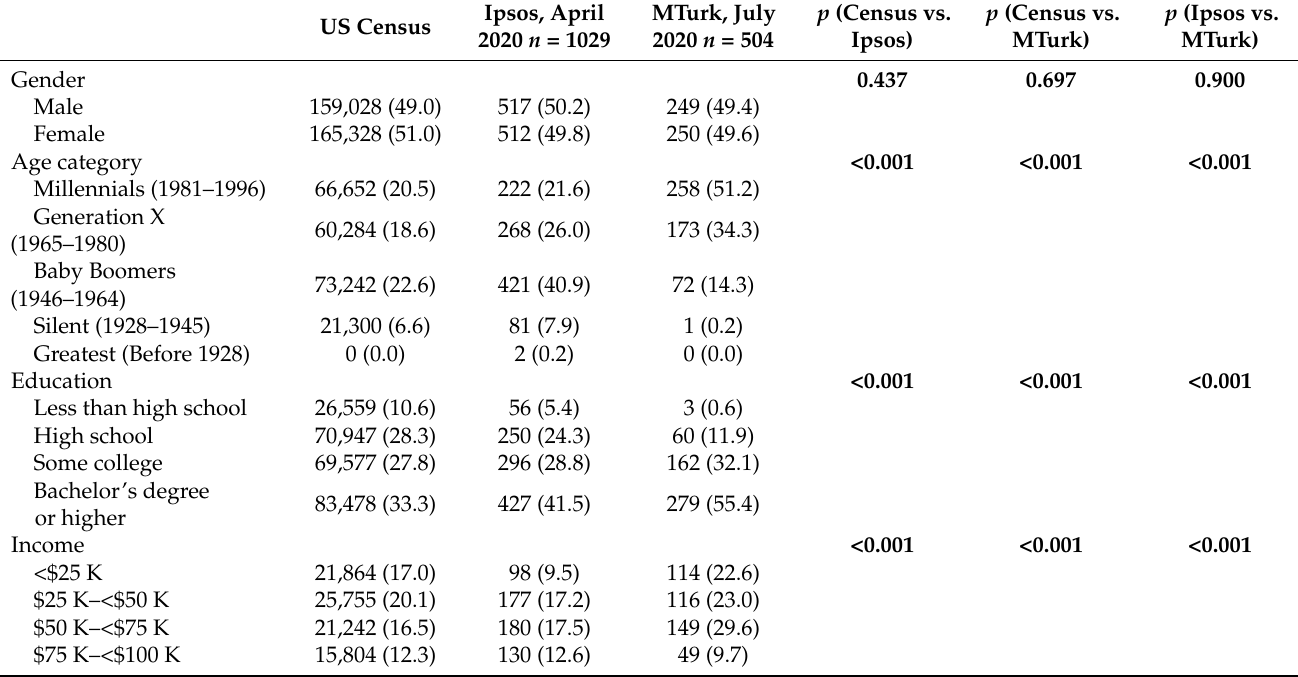
Table 1. Demographic similarities and differences across US Census, Ipsos, and MTurk